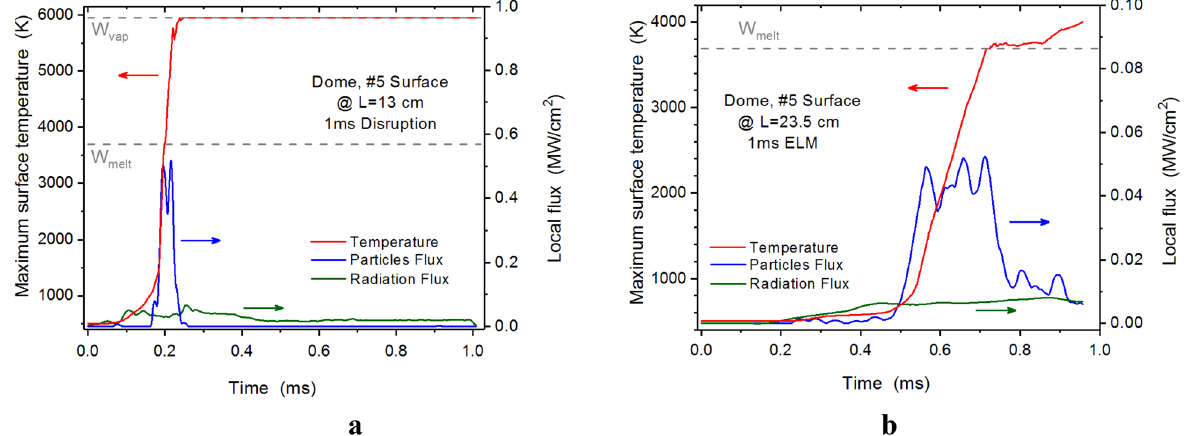
Figure 4. Hot spots on the Dome surface during a disruption ( a ), and during an ELM ( b ). The images were prepared using OriginPro